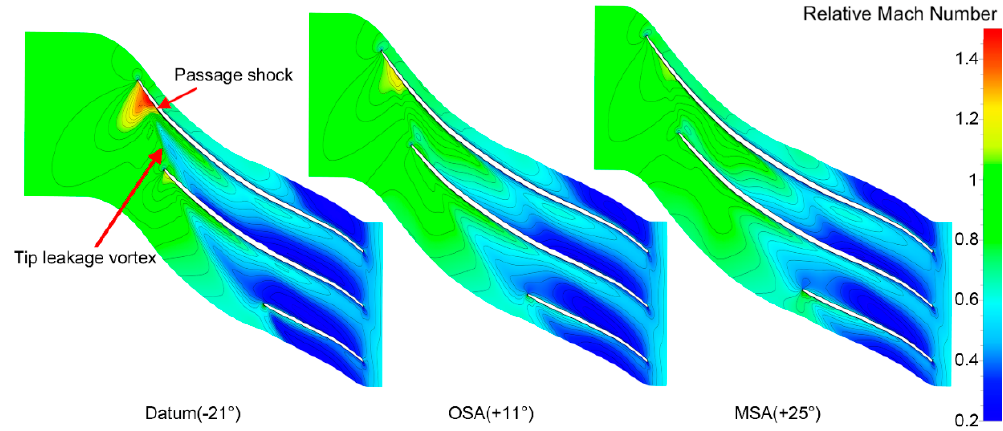
Figure 18. Contours of relative Mach number at 95% span.